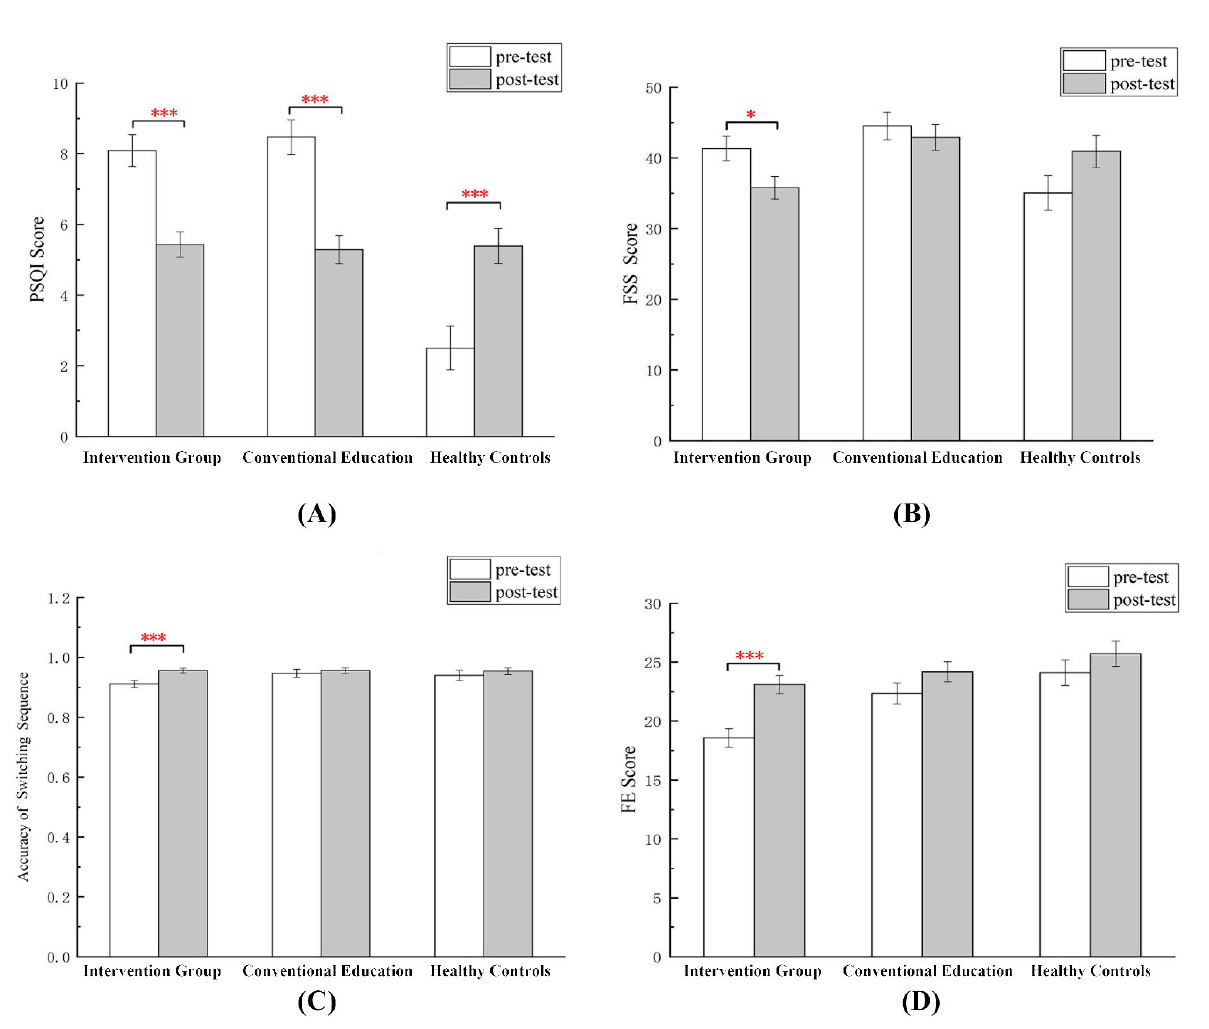
Figure 3. Means with standard error bars for changes in ( A ) PSQI score; ( B ) FSS score; ( C ) switch tasks accuracy; ( D ) FES score from baseline to follow-up between the intervention, conventional education, and healthy control groups. * p < 0.05; *** p <